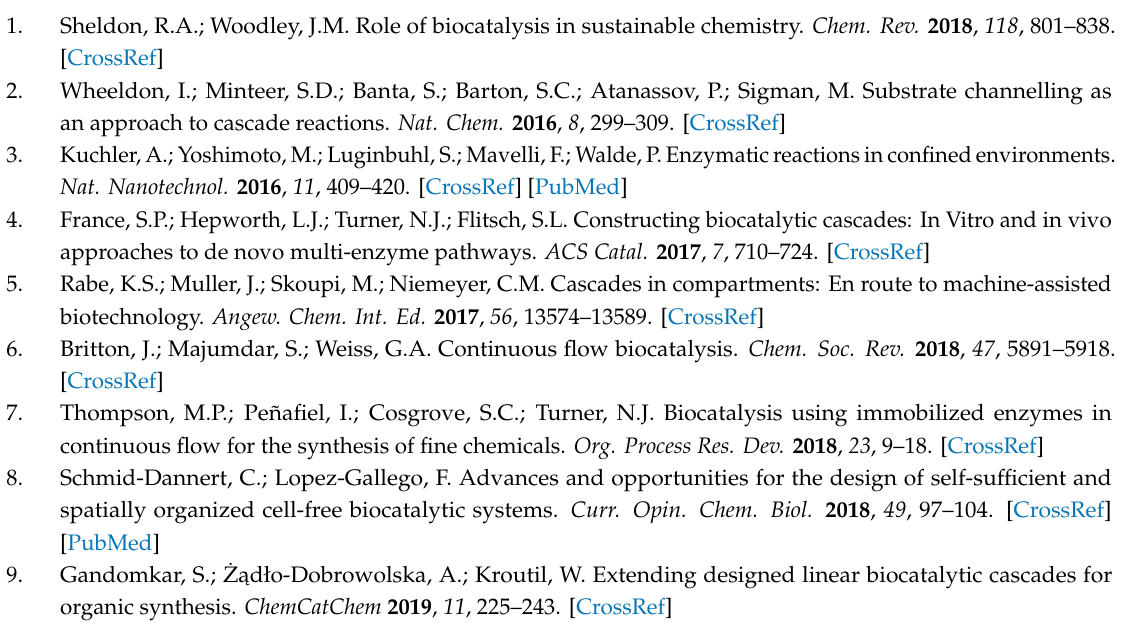
Figure S1: SDS-gel electrophoretic analysis of purified proteins used in this study. Figure S2: Dynamic Light Scattering (DLS) and optical microrheology measurements of the GDH-SC / GF3546-ST gels. Figure S3: Representative HPLC traces of 3,4-Dihydroisoquinoline 2 and the corresponding Amine 2a . Figure S4: Representative HPLC traces of 6,7-Dimethoxy-1-methyl-3,4-dihydroisoquinoline 3 and the corresponding Amines 3a and 3b